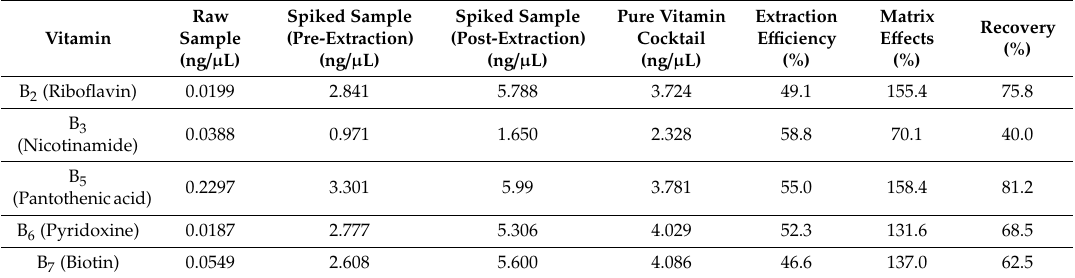
Table 3. Extraction e ffi ciency and percentage recovery estimation for new method.